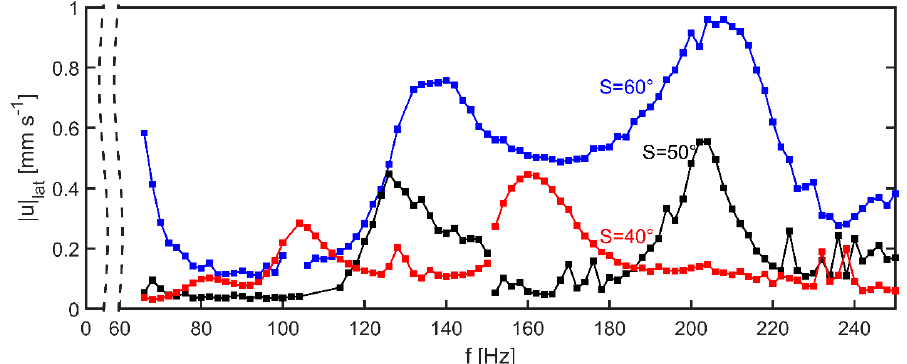
Figure 6. | u | lat measured inside reactors with di ff erent wall slope S in dependence of excitation. Because lower resonance modes are less intense, experiments at lower frequencies were performed with double volumetric power input of 600 W · m − 3 . The change between high and low input power is indicated as interruption of the line connecting data points (at 150 Hz for S = 40 ◦ and S = 50 ◦ and at 100 Hz for S = 60 ◦ ). Experiments which are not being shown here are those with S = 55 ◦ where similar results to S = 50 ◦ were obtained as well as experiments with S = 45 , leading to similar results as S = 40 ◦ .